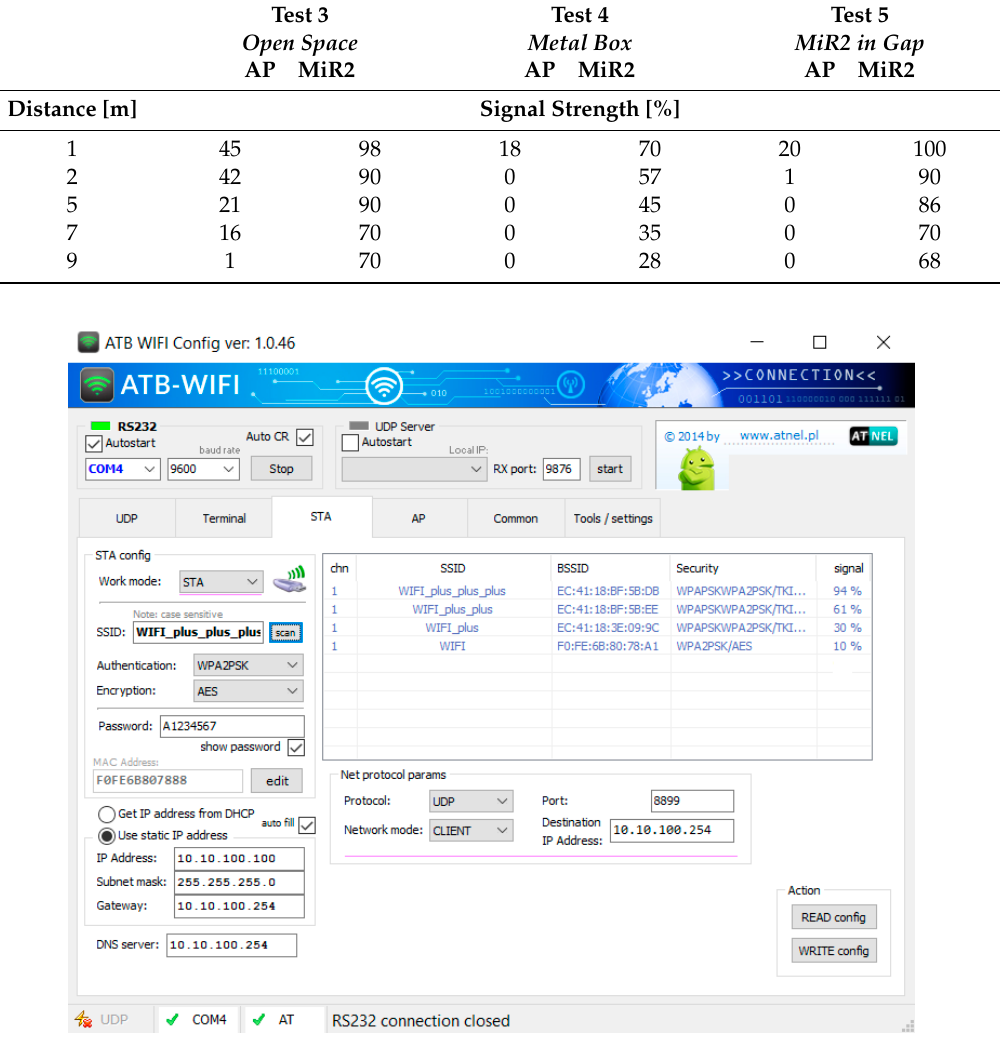
Table 2. The results of the AP and MiR2 strength signals during the tests 3-5.